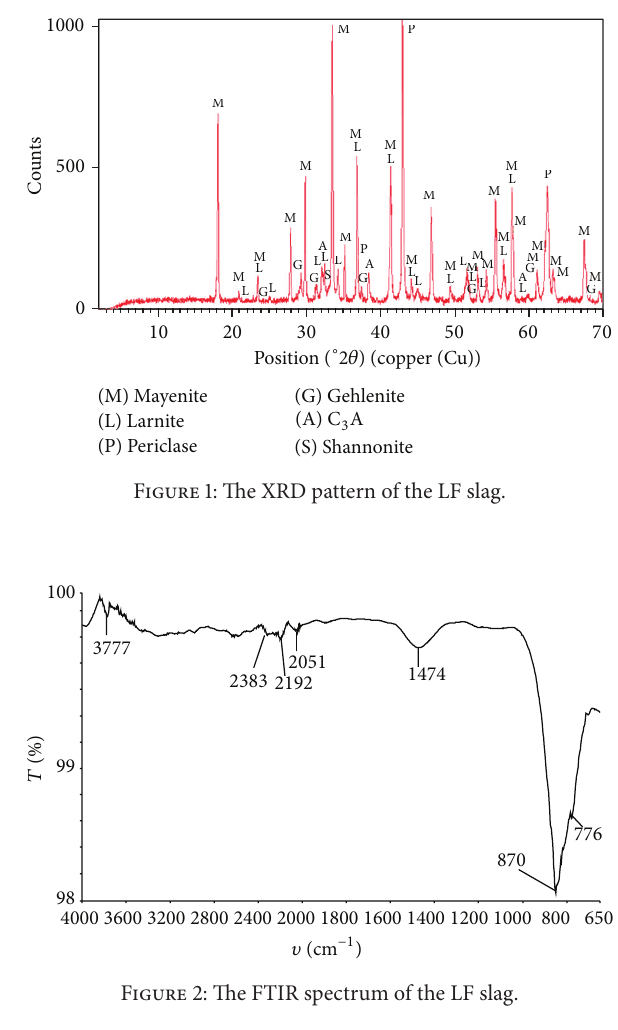
Figure 2. Absorptions correspond to the dominant phases: periclase and mayenite at 1474 and 870 cm −1 ,